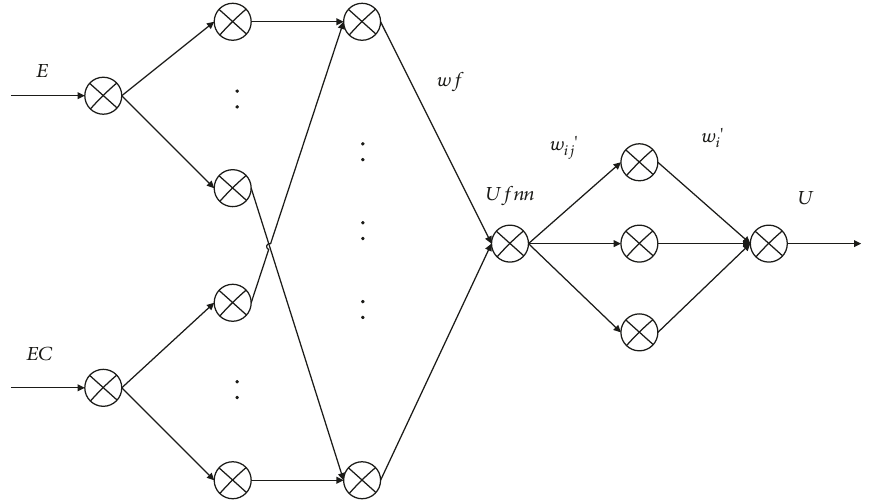
Figure 8: The PID topological structure of the